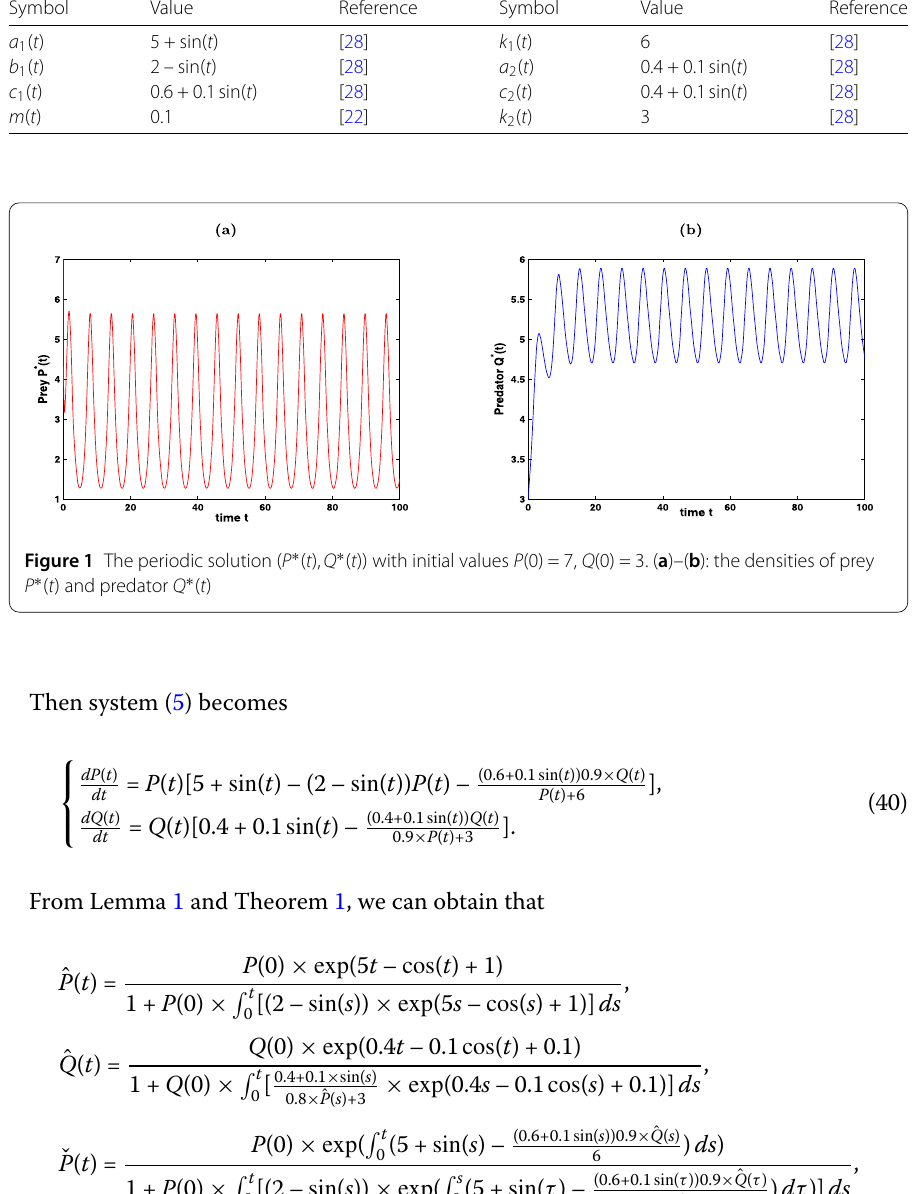
Table 1 Values of the parameters Symbol